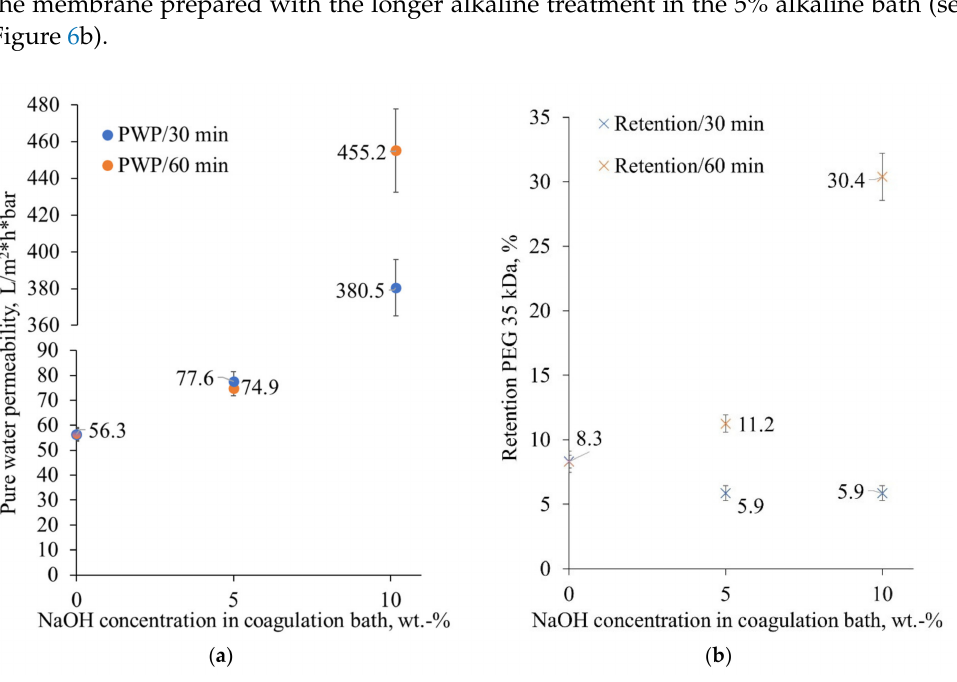
Figure 6. The pure water permeabilities (PWP) ( a ) and PEG 35 kDa retentions ( b ) of the tested membranes, all measured in the Amicon ultrafiltration cell at 25 ◦ C and with a mixing rate of approximately 300